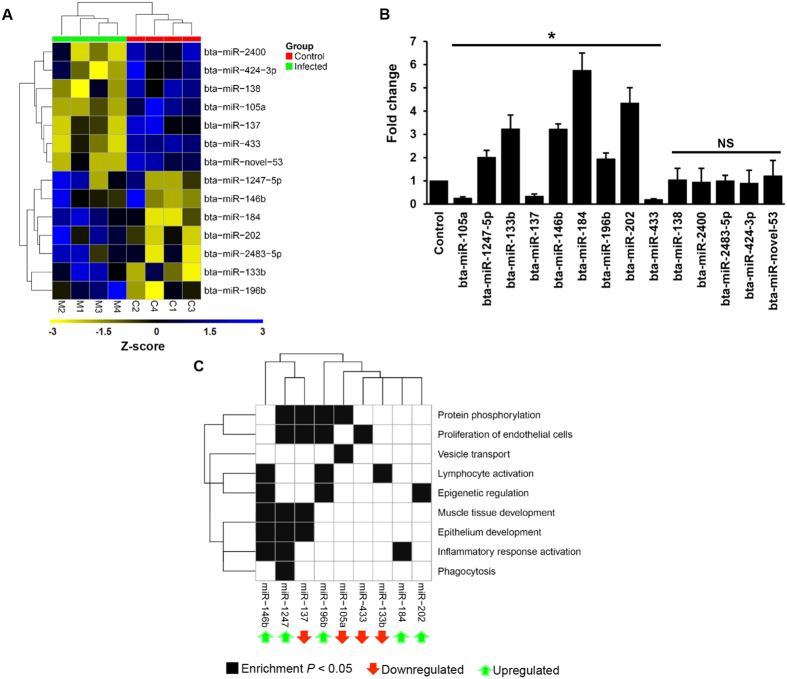
Analysis of differentially expressed miRNAs.(A) Heatmap of differentially expressed miRNAs based on RNA-Seq expression data. Blue indicates a higher expression level, whereas yellow represents a lower expression level. (B) Validation of miRNA expression using stem-loop RT-qPCR. Y-axis presents fold change of miRNA when infected tissues were compared to control tissues. *significant difference at P < 0.05; NS: no significant difference. Data presented as mean ± standard error of the mean (SEM). (C) GO term enrichment of miRNA targeted genes. Targeted genes were identified on the basis of two criteria: computational prediction and negative correlation analysis, r < −0.5, P < 0.05, Pearson’s correlation analysis. Black squares represent functions with significant enrichment (P < 0.05) that were identified by PANTHER. Red/green arrows indicate miRNAs were down-/up-regulated, respectively, in infected compartments.